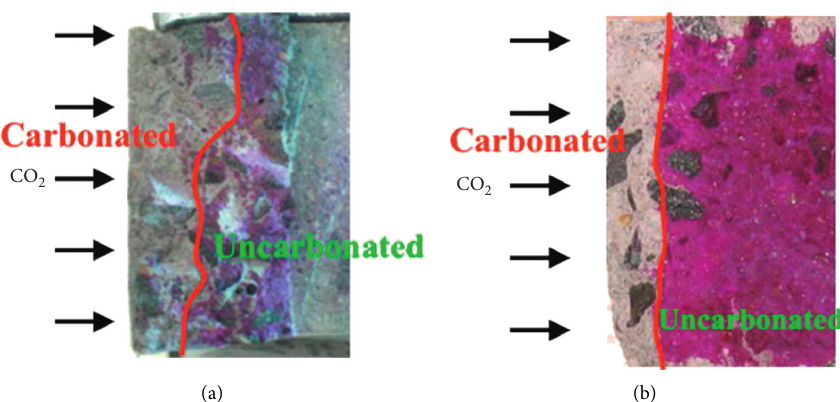
Figure 7: Split section after the phenolphthalein spray of (a) 50% fly ash HVFA concrete and (b) OPC concrete, reproduced from [71], with permission from Elsevier, 2021.